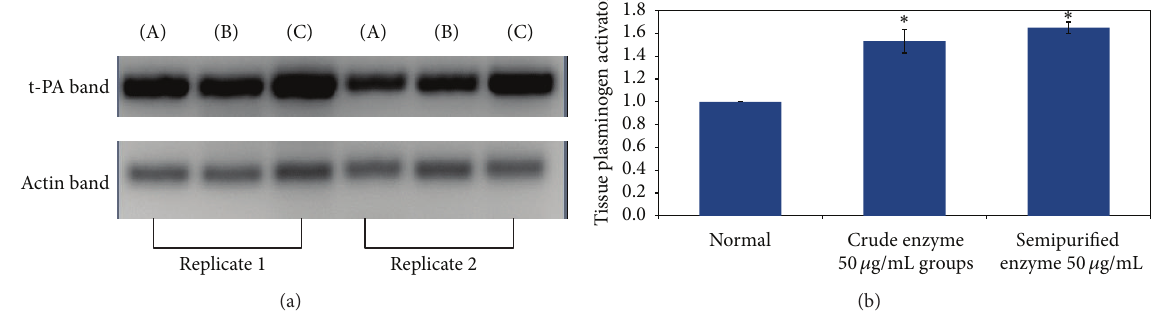
Figure 2: Tissue plasminogen activator expression and quantitative PCR result in HeLa S3 cells. t-PA expression gene in HeLa S3 cells (a); (A) normal control, (B) crude enzyme of Stenotrophomonas sp. 50 𝜇 g/mL, and (C) semipurified enzyme of Stenotrophomonas sp. 50 𝜇 g/mL; quantitative PCR (b). ∗ significant difference compared with normal ( 𝑝 < 0.05 ).